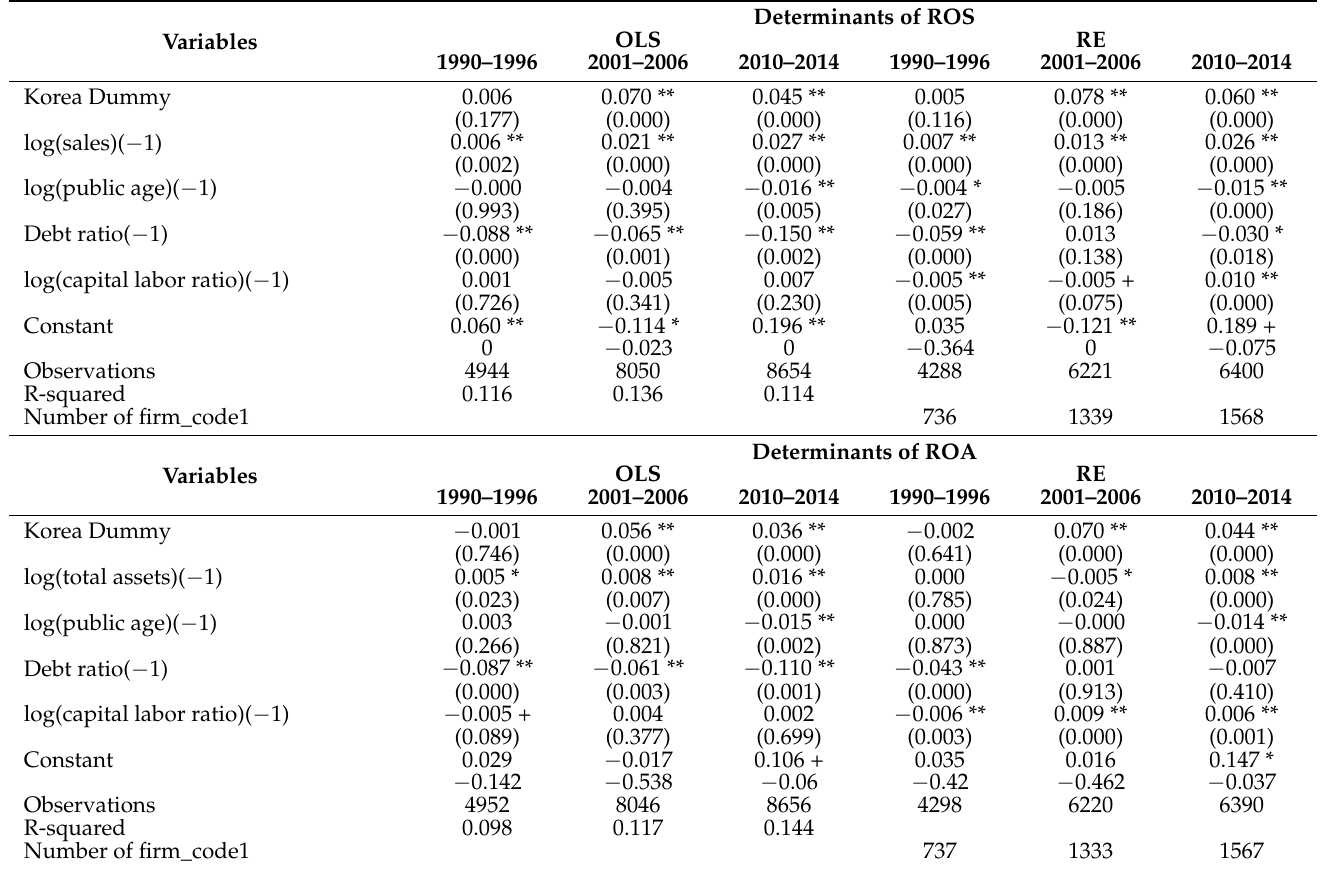
Table 5. Comparison of profitability (ROS, ROA) by